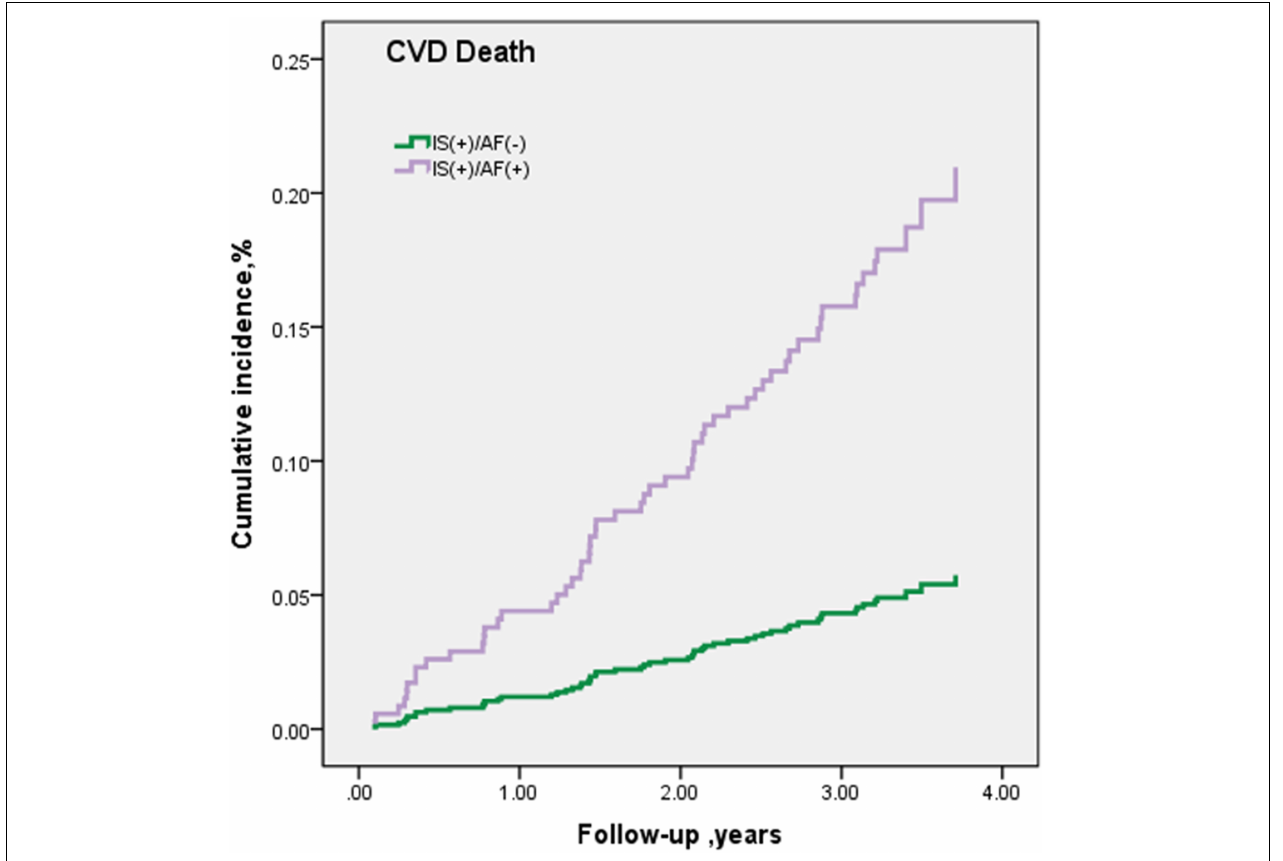
FIGURE 3 | CVD death during follow-up